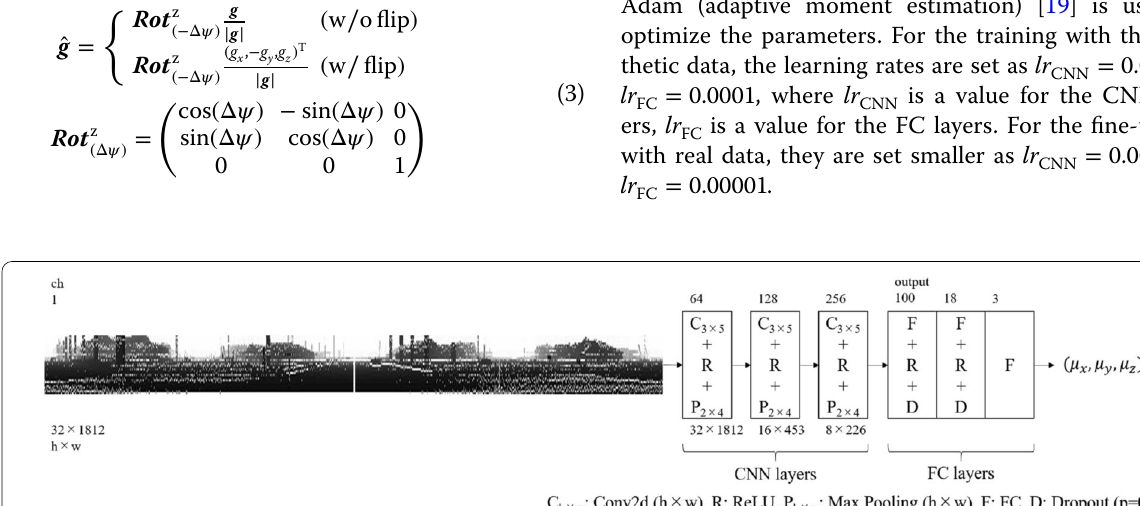
Fig. 5 Proposed network architecture. It consists of CNN layers and FC layers. The MSE between the outputs and the labels is used as a loss function of this